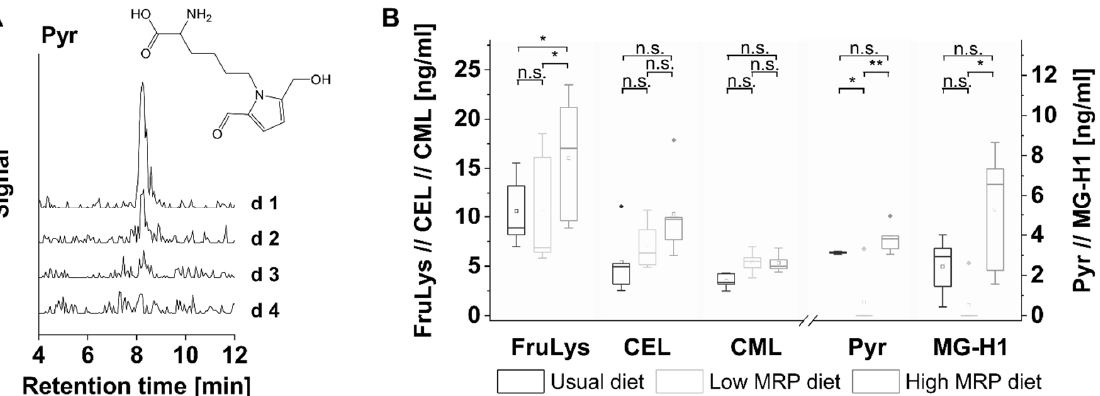
Figure 2. ( A ) LC-MS/MS chromatogram of pyrraline (Pyr) in saliva samples of one subject on four consecutive days during low MRP diet; ( B ) comparison of dietary styles: boxplot of salivary MRP concentrations of five subjects during usual diet, on day 5 of the low MRP diet and on day 5 of the high MRP diet. The box contains 50% of data and includes the mean of the data (demonstrated by the square in the box) and the median (demonstrated by the line in the box). Outliers are indicated by a rhombus. Significance:, ** p < 0.01, * p < 0.05, n.s.—not significant. For salivary free CML and CEL, no pronounced difference between low and high MRP intake was observed. In our study based on saliva as a body fluid, both carboxyalkyl amino acids (CML and CEL) were not altered by dietary